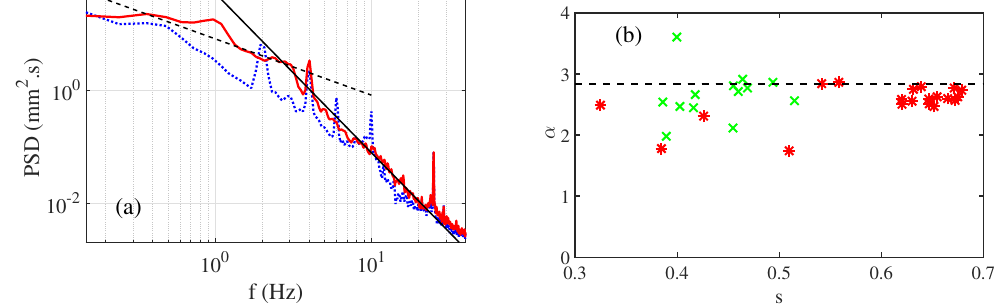
( f ) (blue dotted line) and S η ( f ) (red continuous Figure 19. ( a ) Power spectrum of wave elevation S η 2 1 line) for a sinusoidal forcing θ 0 = 0.04 and F = 2Hz. The power laws f − 17/6 and f − 1 are also indicated, respectively, as a black continuous line and as a black dashed line. ( b ) For the sensor 2 only, a fitted exponent of the power spectrum S η ∼ f − α as a function of the steepness S . ∗ —sinusoidal forcing, × —sensor 2 random forcing. The horizontal dashed line indicates the value predicted by the capillary wave turbulence theory α theo = 17/6. ∗ —sinusoidal forcing, × —random forcing. (Reprinted with permission from Ref. [115] Copyright 2022 European Physical